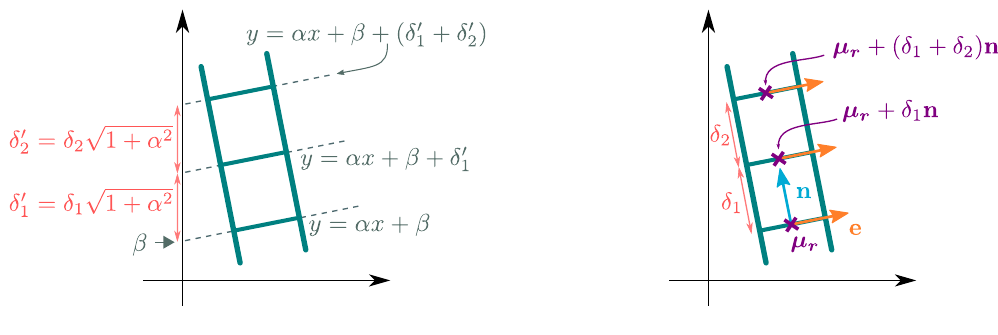
Figure 18. Simultaneous affine ( Left ) and orthogonal ( Right )